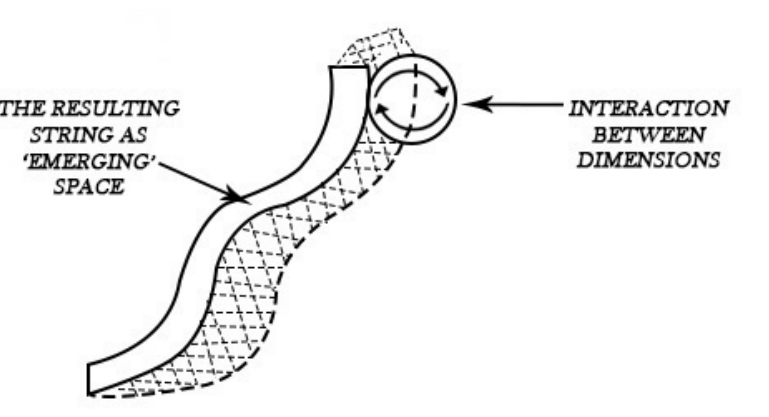
Figure 2. A 2 − 1- PNDP is shown, i.e., ( I 1 × I 2 ) × ( R + E ) . From the interaction between the positive and virtual negative dimensions, a line interval emerges, topologically equivalent to a